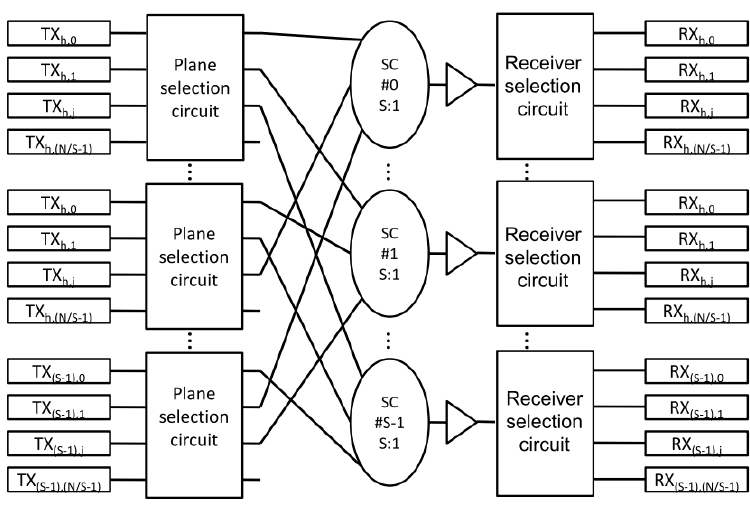
Figure 1. General multiplane switching